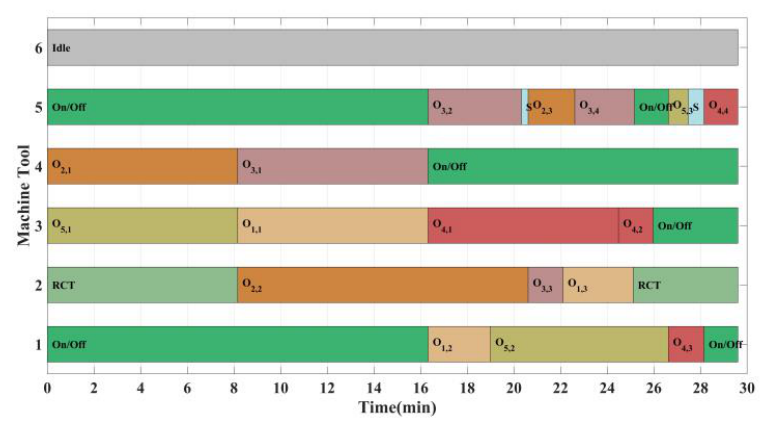
Figure 22. Gantt chart of an instance.